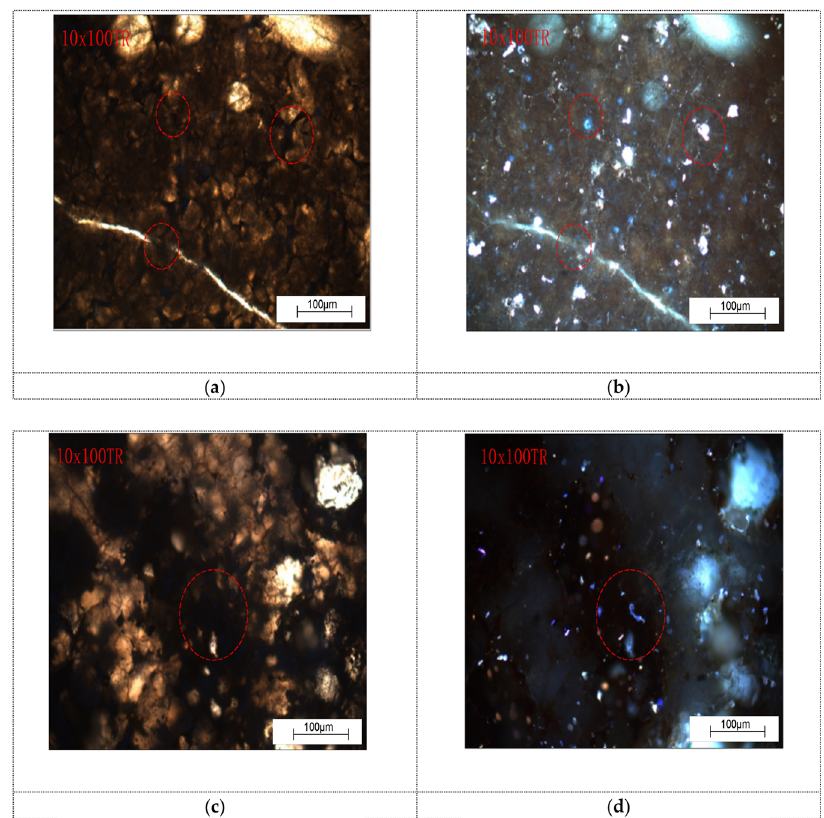
Figure 4: Dark brown asphalt without fl uorescence of electron microscopes. ( a and b ) Gray brown asphalt with limestone cracks observed under transmission light and ( c and d ) asphalt with limestone cracks observed under ultraviolet